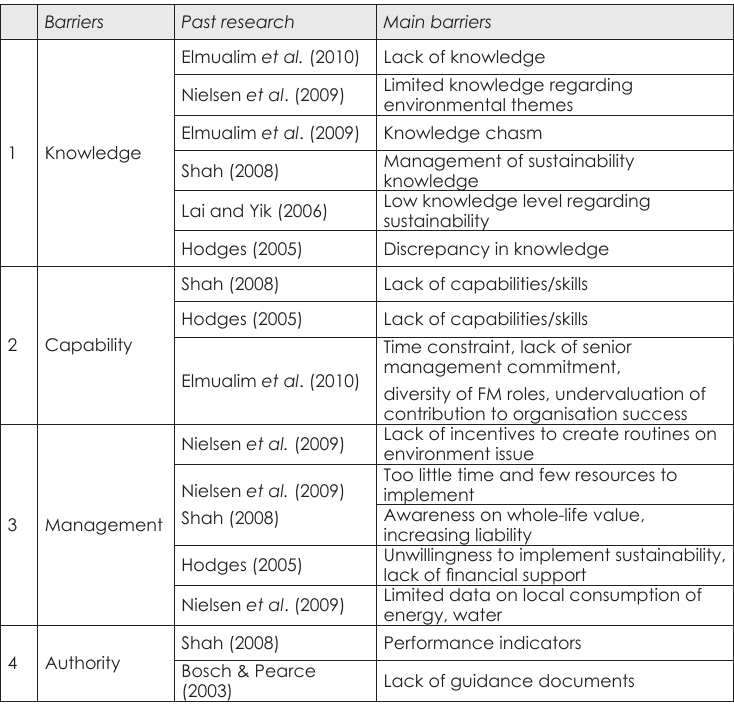
Barriers to the implementation of sustainable FM practices in organisations